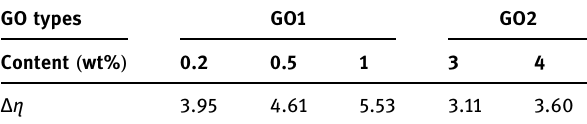
Table 3: Viscous activation energy of PAN/GO/DMSO blend solution ( γ = 1 s − 1 ) GO types